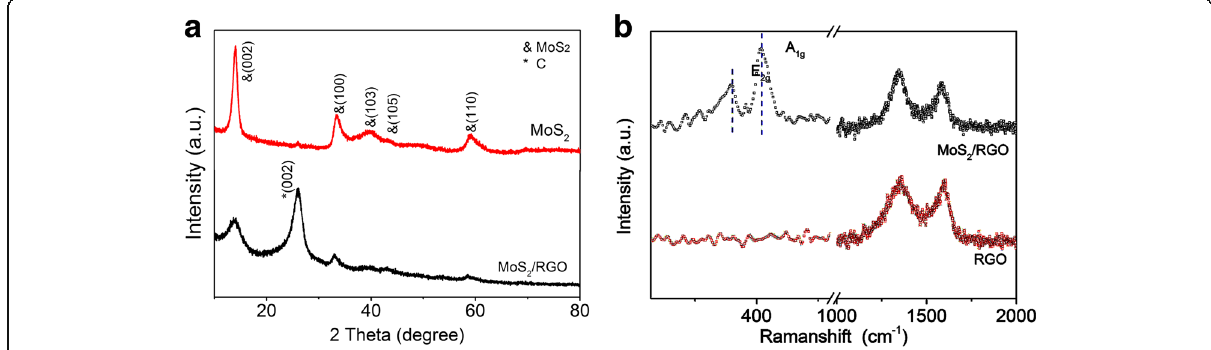
Fig. 3 a XRD patterns of MoS2/RGO and MoS2 samples. b Raman spectra of the MoS2/RGO and